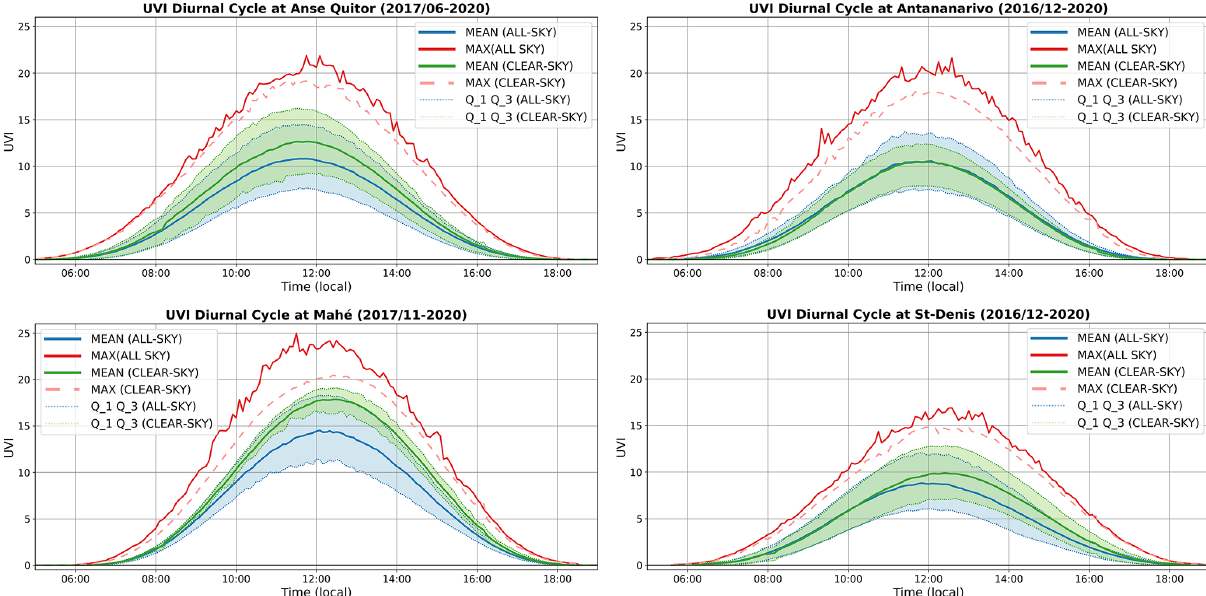
Figure 5. Diurnal cycle of UVI at Anse Quitor, Antananarivo, Mahé, and Saint-Denis. In all-sky conditions, mean UVI is in blue, max UVI is in red, and first and third quartiles delimit the blue shaded area. In clear-sky conditions, mean UVI is in green, max UVI is in dashed red, and first and third quartiles delimit the green shaded